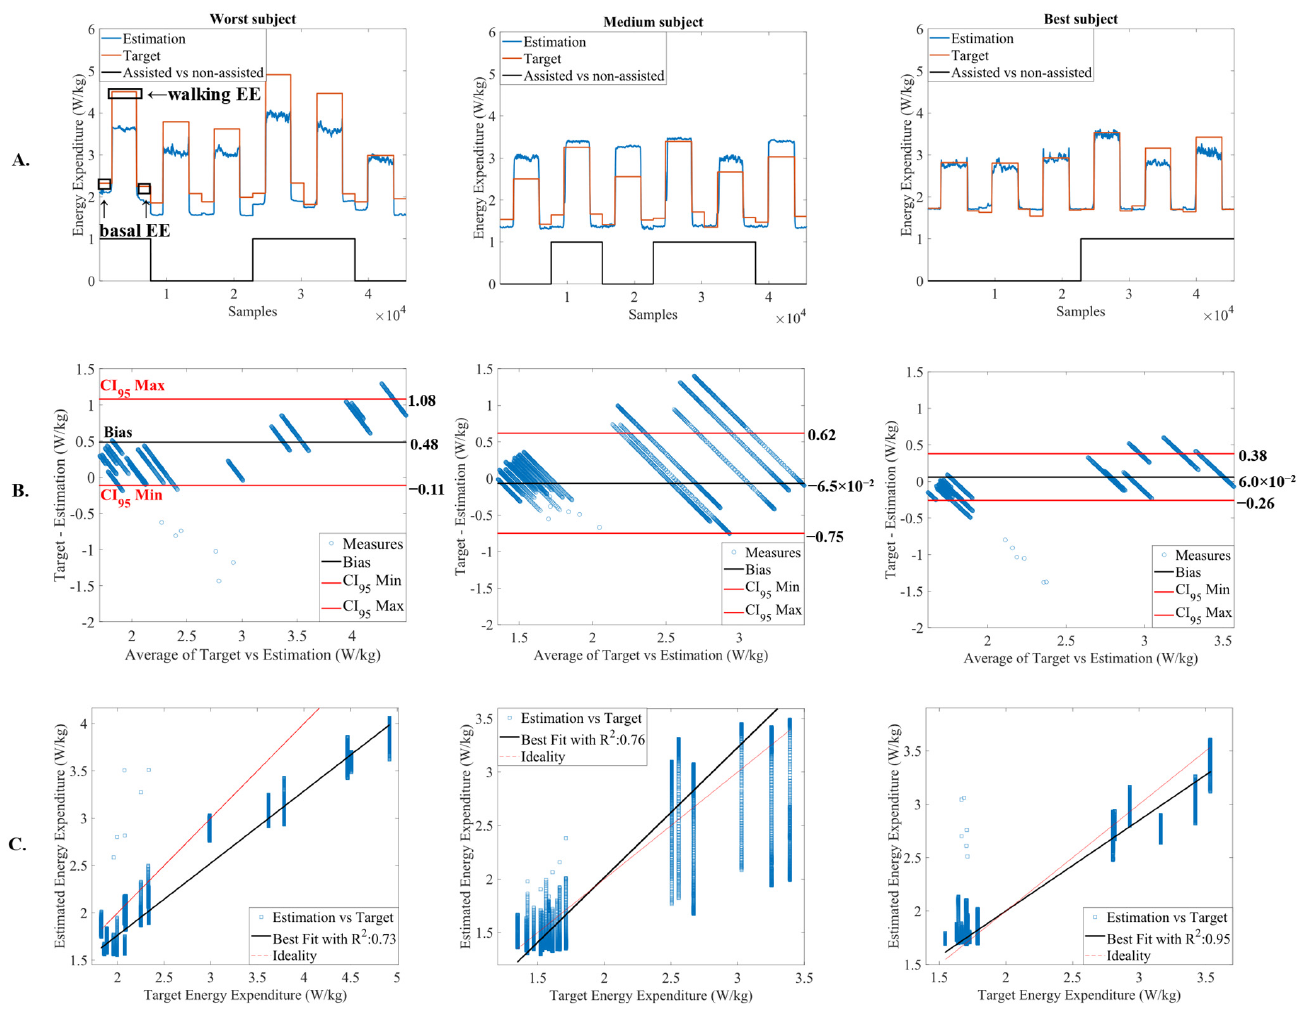
Figure 5. ( A ) energy expenditure (EE) estimation for the worst, medium, and the best prediction subject of LOOCV algorithm, marking assisted and non-assisted gait, and basal and walking energy expenditure; ( B ) Bland-Altman plot of target vs. estimation for the worst, medium, and the best prediction subject; and ( C ) linear regression plot with the coefficient of determination (R 2 ) for the worst, medium, and the best prediction subject of LOOCV algorithm.